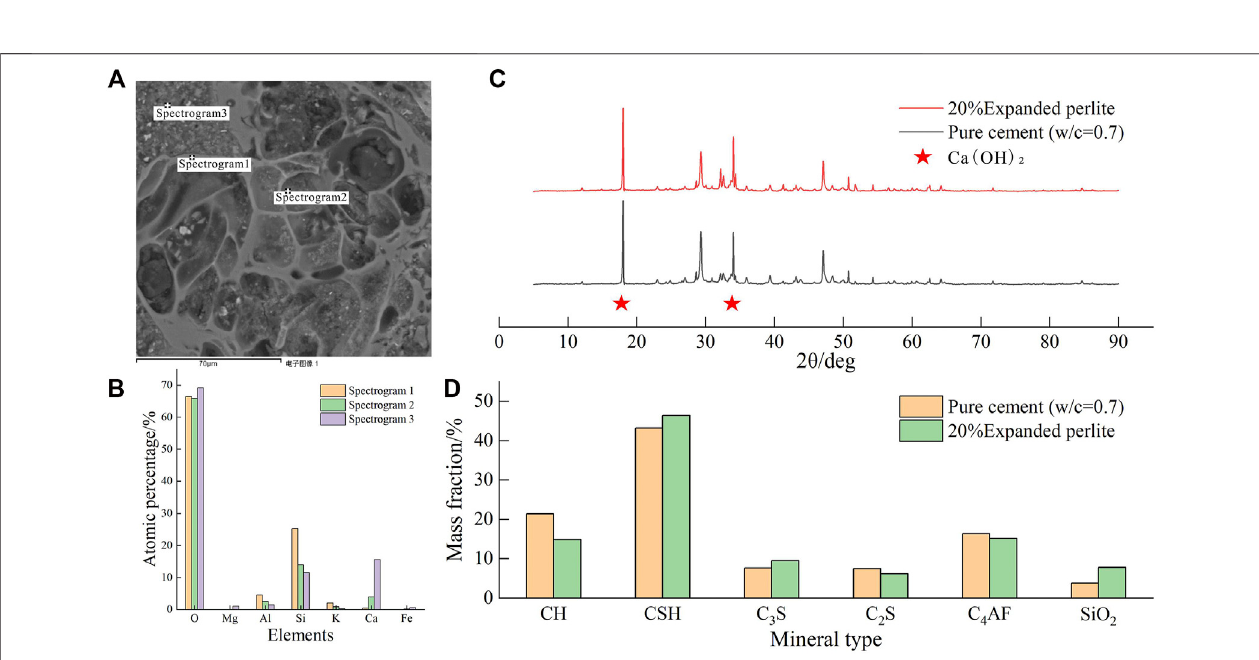
FIGURE9| EnergyspectrumanalysisandXRDtestresultsofthermalinsulationcementwithexpandedperlite. (A) Theselectedpointsofspectrograms. (B) Atomic number statistics from energy spectrum analysis results. (C) XRD test results of pure cement (w/c = 0.7) and thermal insulation cement with 20% expanded perlite. (D) Mineral content statistics of XRD test